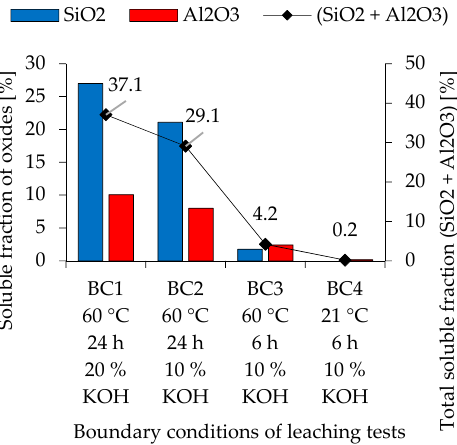
Figure 2. Soluble fraction of oxides and total soluble fraction of oxides of fly ash (ICP-OES of eluates).